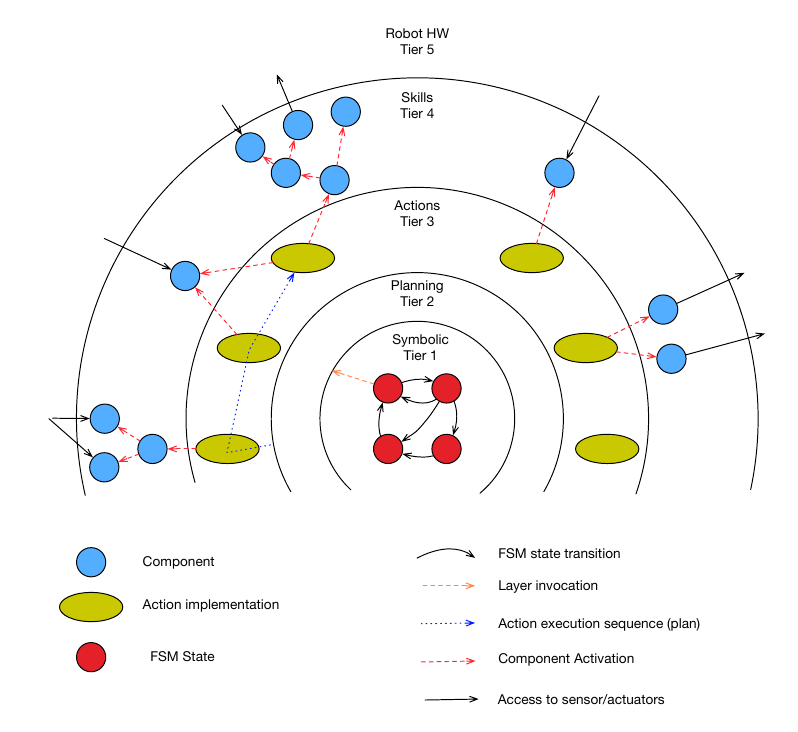
Figure 5. Layered planning-centered